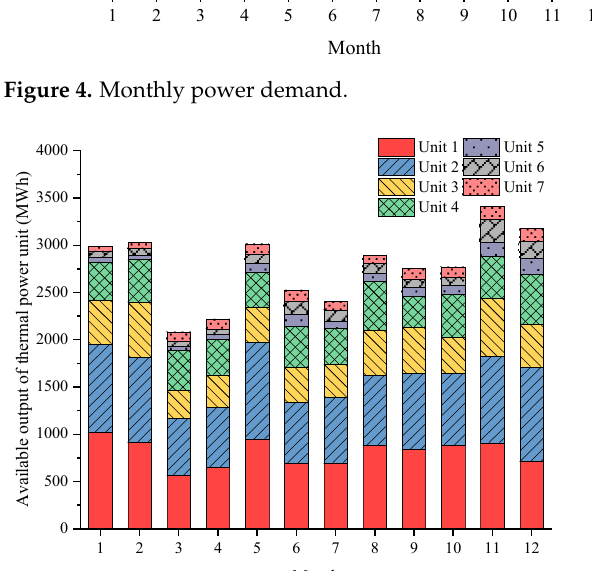
Figure 5. Monthly available thermal-power output.